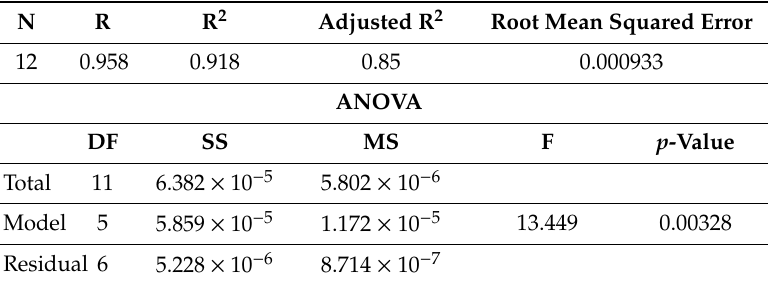
Table 7. Diameter Model Summary.